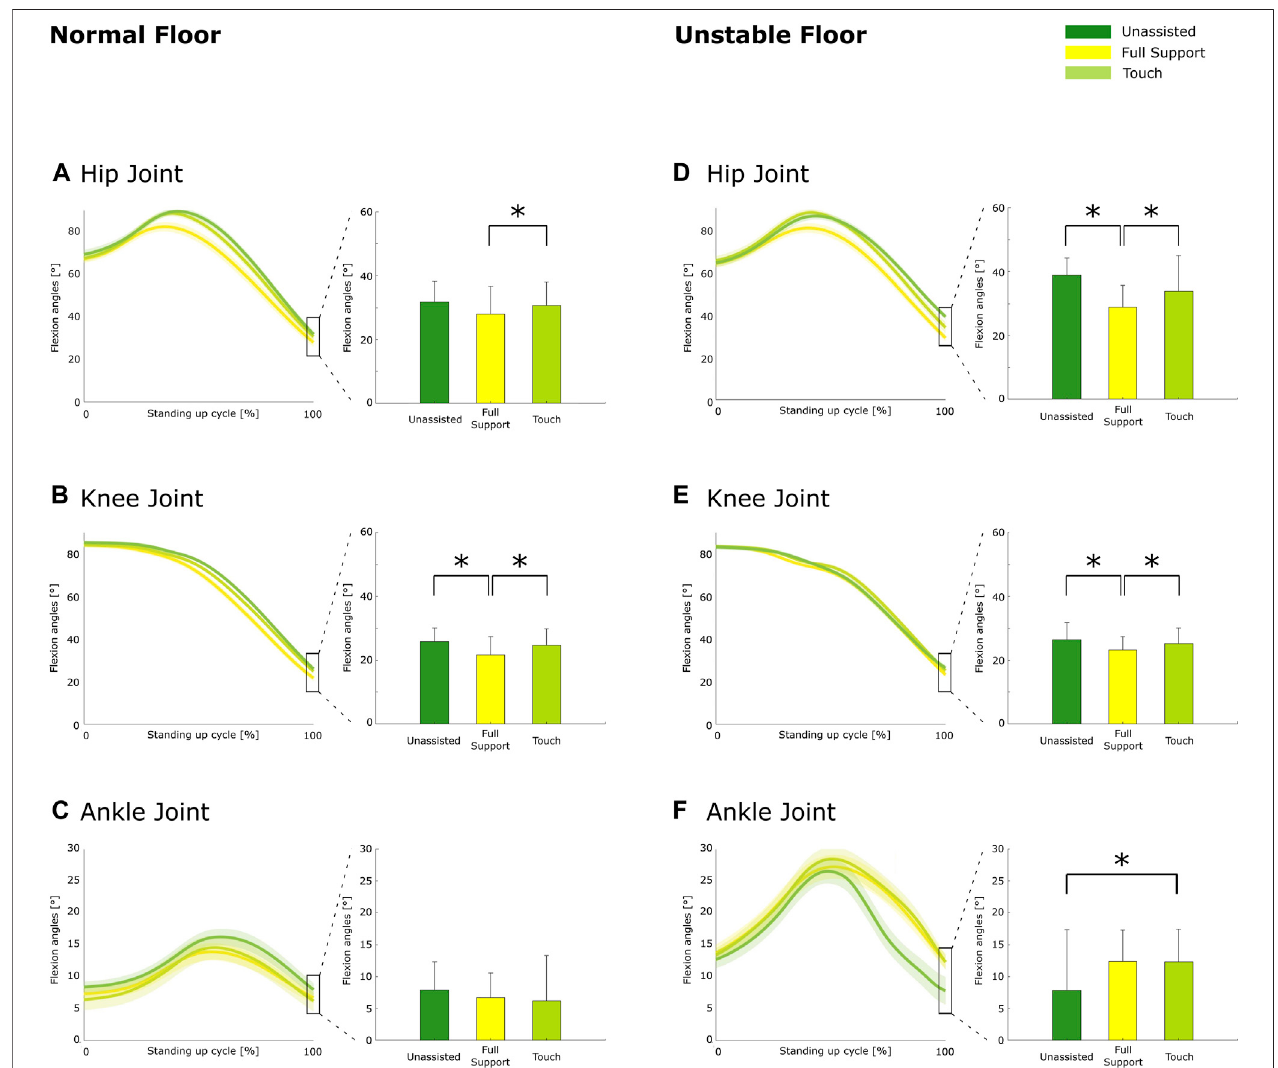
FIGURE5| Sagittalplanekinematicsatastablestanceonthenormal fl oorforthehip (A) ,knee (B) ,andankle (C) andontheunstable fl oorforthehip (D) ,knee (E) , and ankle (F) . On the left side, motion-normalized trajectories are shown with values at a stable stance on the right. Group averages are shown with the bold line, and shaded areas indicate the standard deviations. The bar represents the mean value, the error bar represents the standard deviations of sagittal joint angles at a stable stance, and the asterisk depicts signi fi cant differences with p ≤ 0.05 (Holm – Bonferroni corrected).